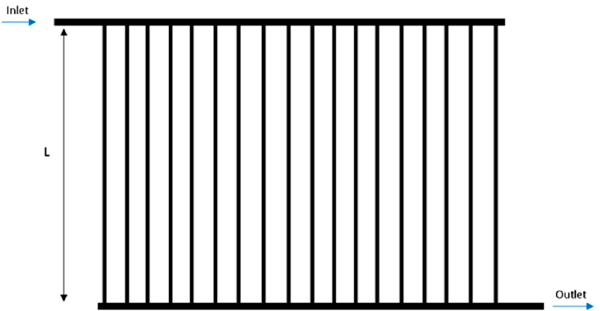
Figure 1. Z-type configuration solar collector, consisting of inlet / outlet manifolds and 18 parallel riser tubes.